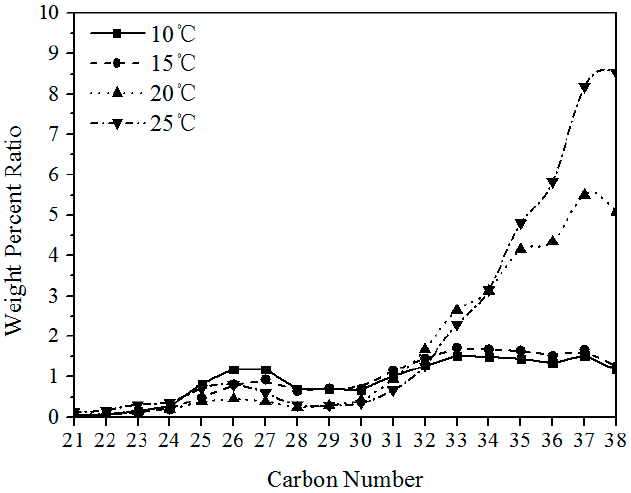
Figure 12. The weight percent ratio of each carbon number in precipitated wax at different temperatures of 15% artificial oil.